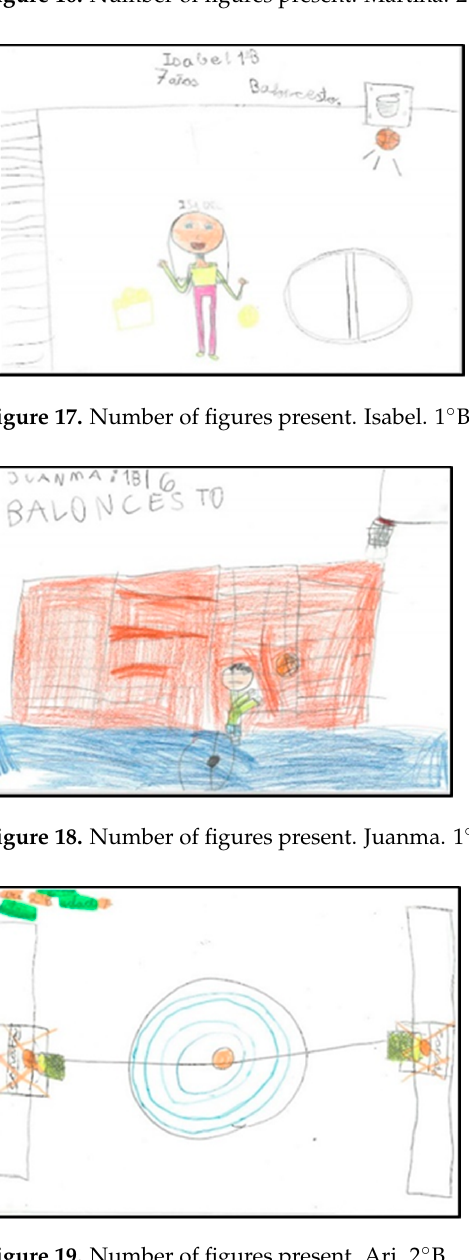
Figure 19. Number of figures present. Ari. 2 ◦